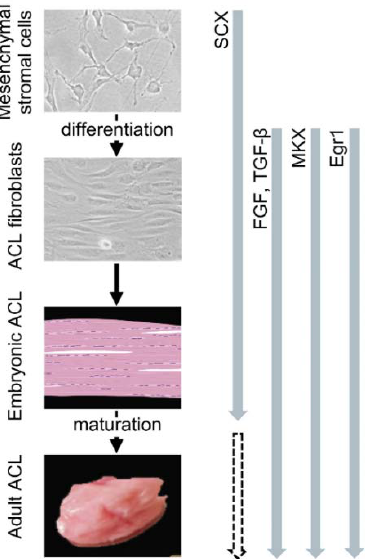
Figure 3. Expression patterns of critical transcription factors during the development of the ACL (SCX, scleraxis; FGF, fibroblast growth factor; TGF- β , transforming growth factor beta; MKX, Mohawk, Egr1, early growth response factor 1).